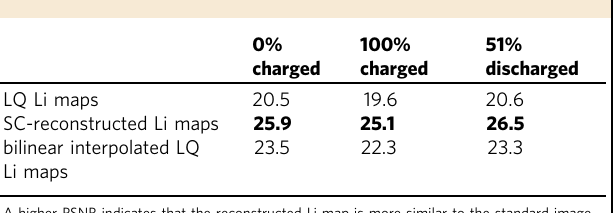
Table 1 PSNR (dB) values of the original LQ, SC-reconstructed, and interpolated (bilinear interpolation) LQ Li maps.